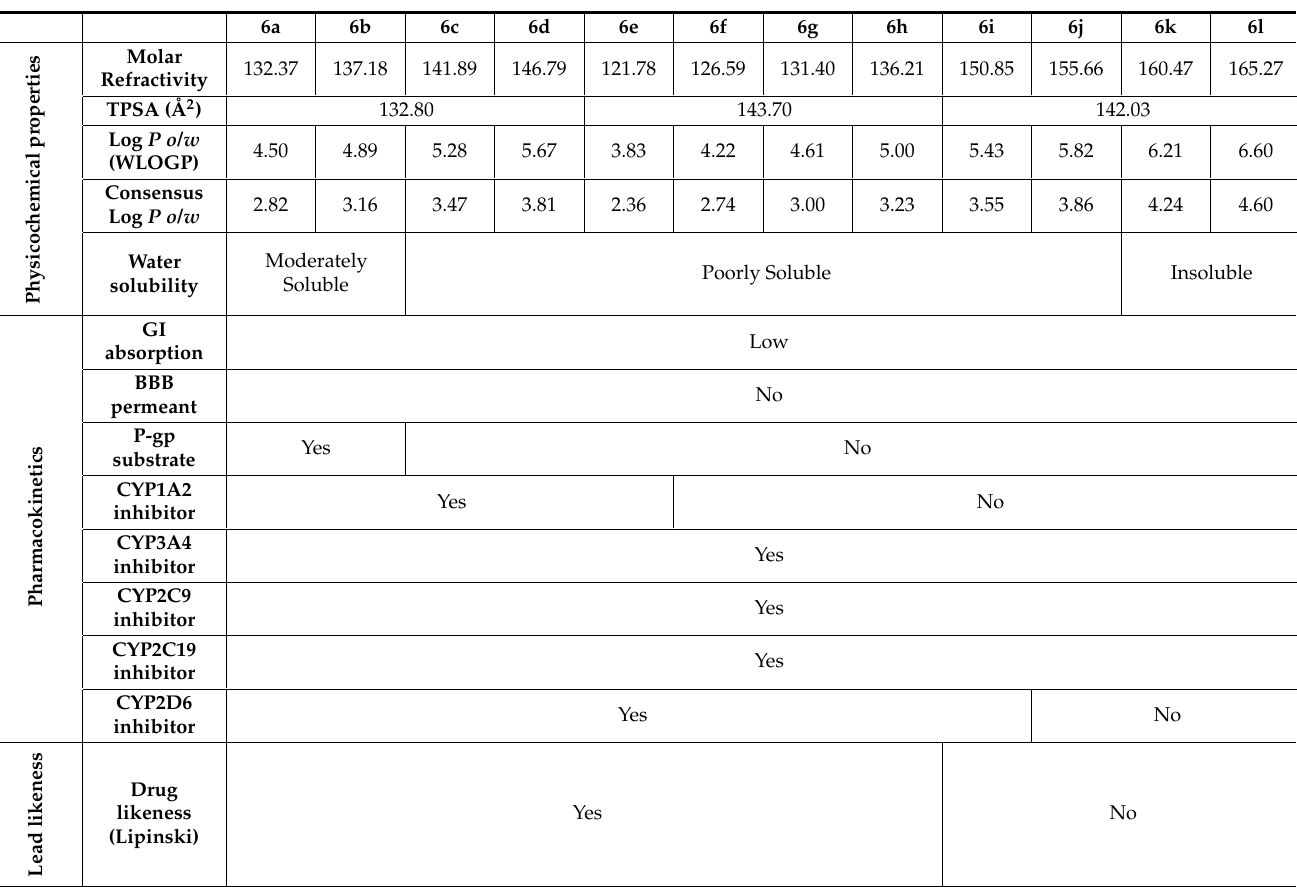
Table 2. Physicochemical properties, pharmacokinetics, and lead likeness studies of the designed candidates 6a – l